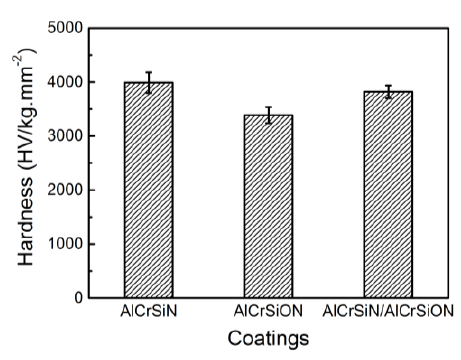
Figure 6. Hardnesses of the AlCrSiN coating, AlCrSiON coating, and AlCrSiN/AlCrSiON duplex coating.